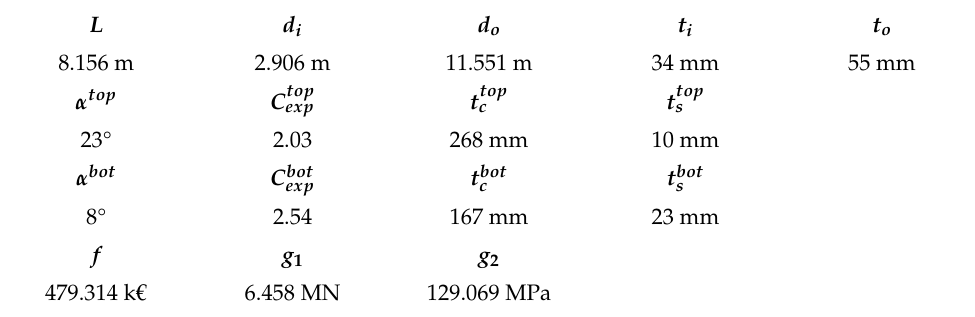
Figure 11. Evolution of the cost of the UBB during the optimization process with the basic GA. Table 10. Design variables, cost and constraint values of the optimized UBB with the basic